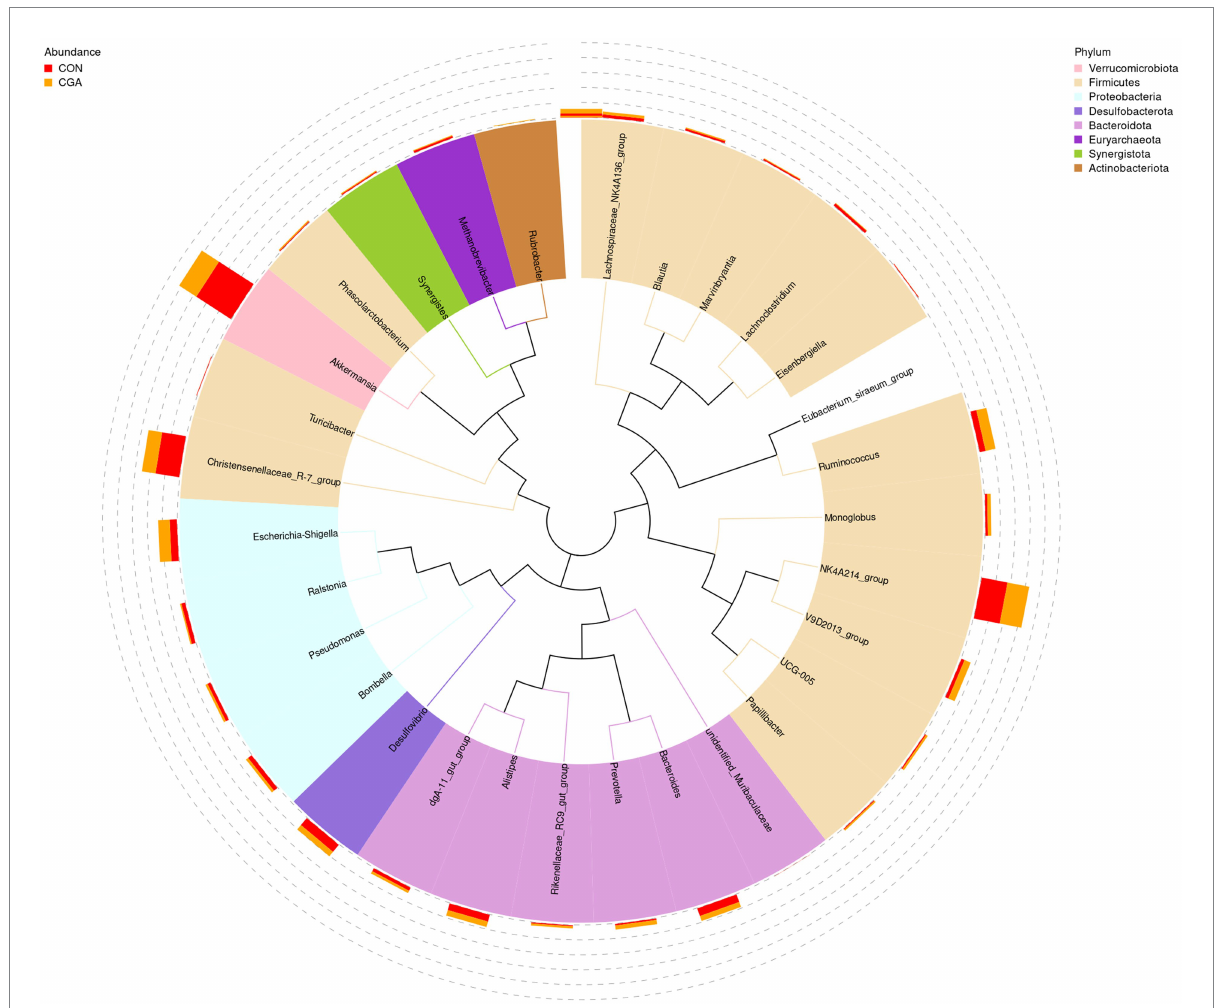
FIGURE 8 Changes of the relative abundance at genus levels. The phylogenetic tree constructed based on the sequence of the top 35 genera. The branches with different colors in the inner circle represent their corresponding phylum, and the stacked column chart in the outer circle indicates the relative abundance of each genus in different treatments. CON, rabbits fed a basal diet; CGA, rabbits fed the basal diet supplemented with 800 mg/ kg chlorogenic